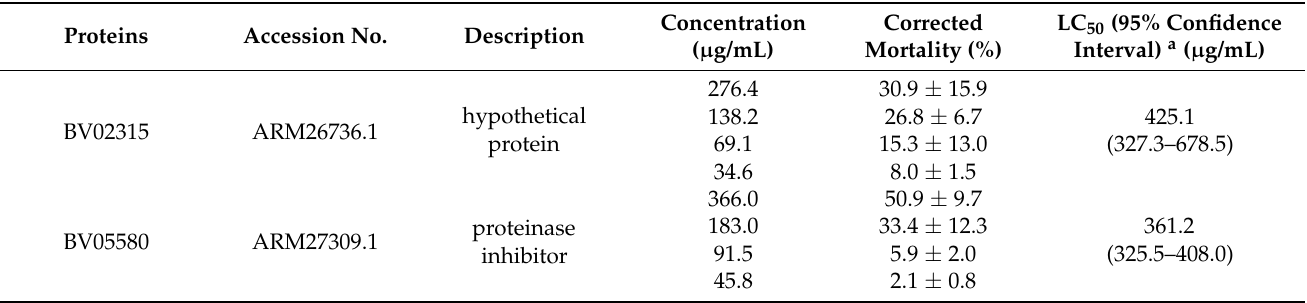
Table 6. Acaricidal activity of purified proteins of Bacillus vallismortis NBIF-001 against Tetranychus urticae